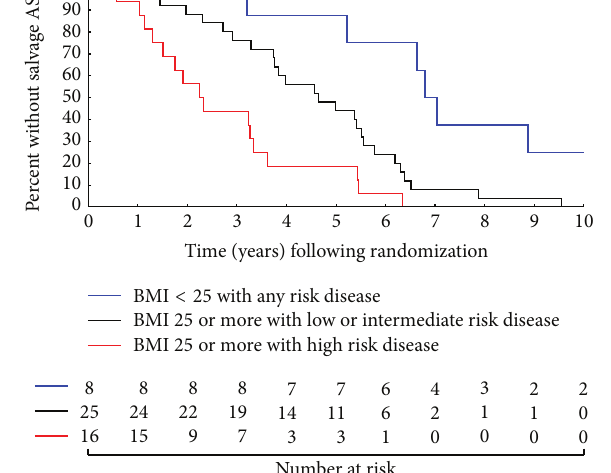
Figure 1: Kaplan-Meier estimates of freedom from receipt of salvage androgen suppression therapy stratified by risk group and the BMI cut point for the upper limit of normal-weight BMI < 25 kg/m 2 with any risk disease versus BMI > 25 kg/m 2 with low or intermediate risk disease ( 𝑃 = 0.005 ), BMI > 25 kg/m 2 with high risk disease versus BMI > 25 kg/m 2 with low or intermediate risk disease ( 𝑃 = 0.005 ), and BMI > 25kg/m 2 with high risk disease versus BMI < 25 kg/m 2 with any risk disease ( 𝑃 < 0.001